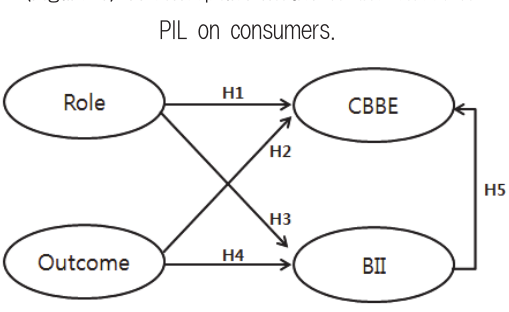
<Figure 1> A conceptual model of the effect of PIL on